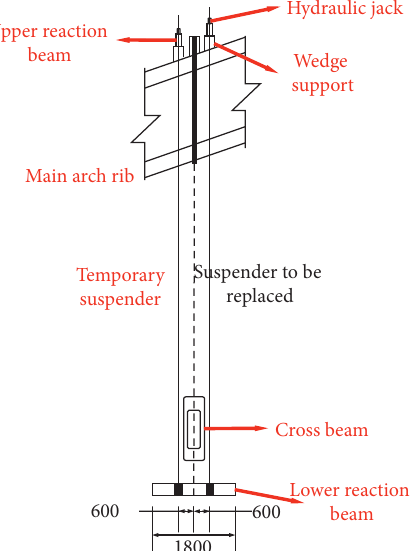
Figure 17: Profile of the temporary suspender system.